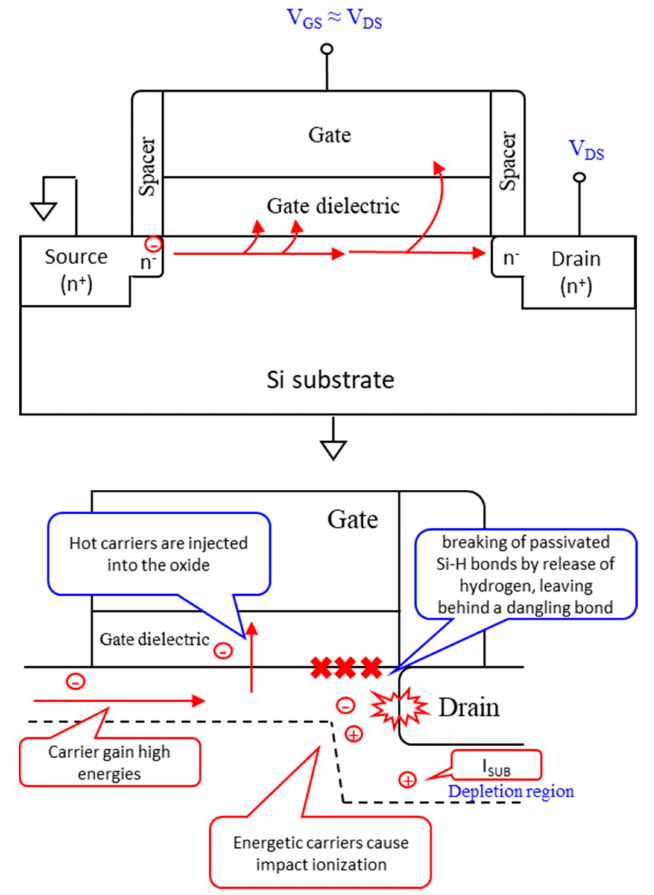
Figure 1. Schematic diagram of channel-hot-carrier